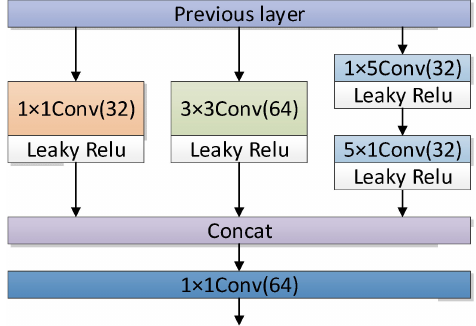
Figure 2. A multi-scale feature extraction